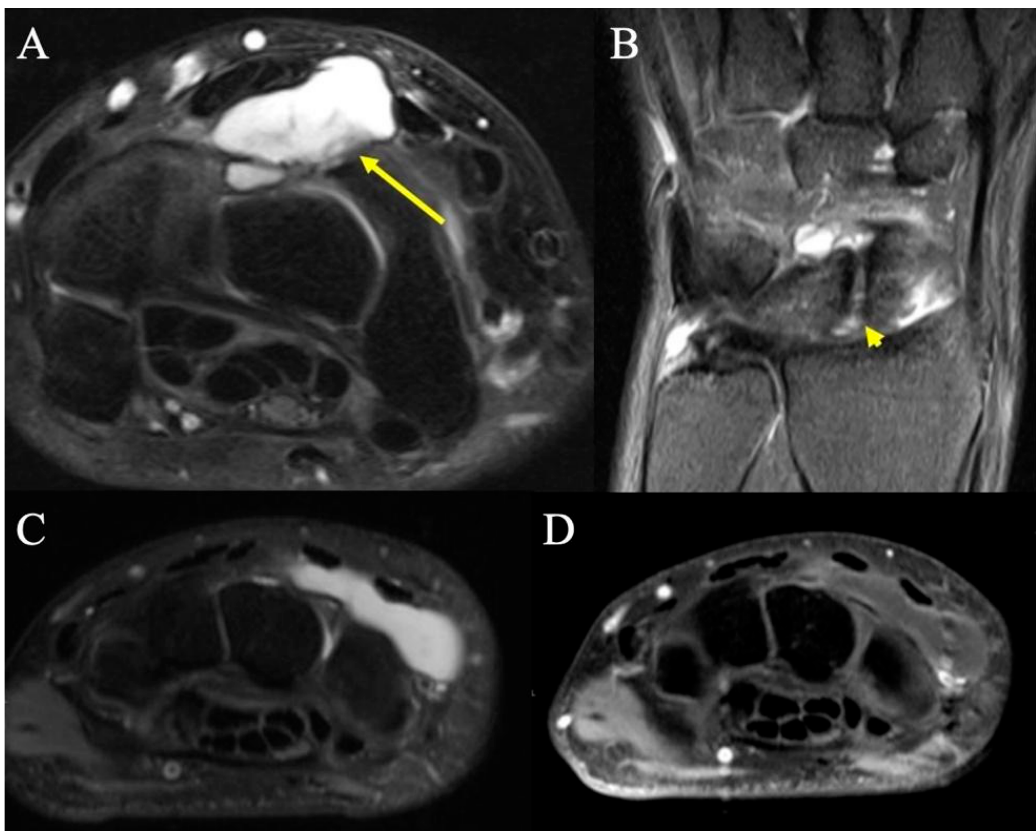
Figure 1. Dorsal ganglion. ( A ) Axial fat-suppressed PD MRI shows a moderate-sized dorsal wrist ganglion (arrow) at the proximal carpal row, between the second and fourth extensor compartments, with large component superficial and a smaller component deep to the dorsal intercarpal ligament. ( B ) Coronal fat-suppressed PD shows the neck of the ganglion arising from small rents (arrowhead) in the dorsal scapholunate ligament. ( C ) T2-weighted MR image showing a dorsal homogenous mass deep to the extensor tendons but superficial to the carpal bones at the level of the wrist, consistent with dorsal ganglion. ( D ) Same dorsal hand mass on a T2-fluid attenuated sequence that appropriately loses signal intensity, consistent with dorsal